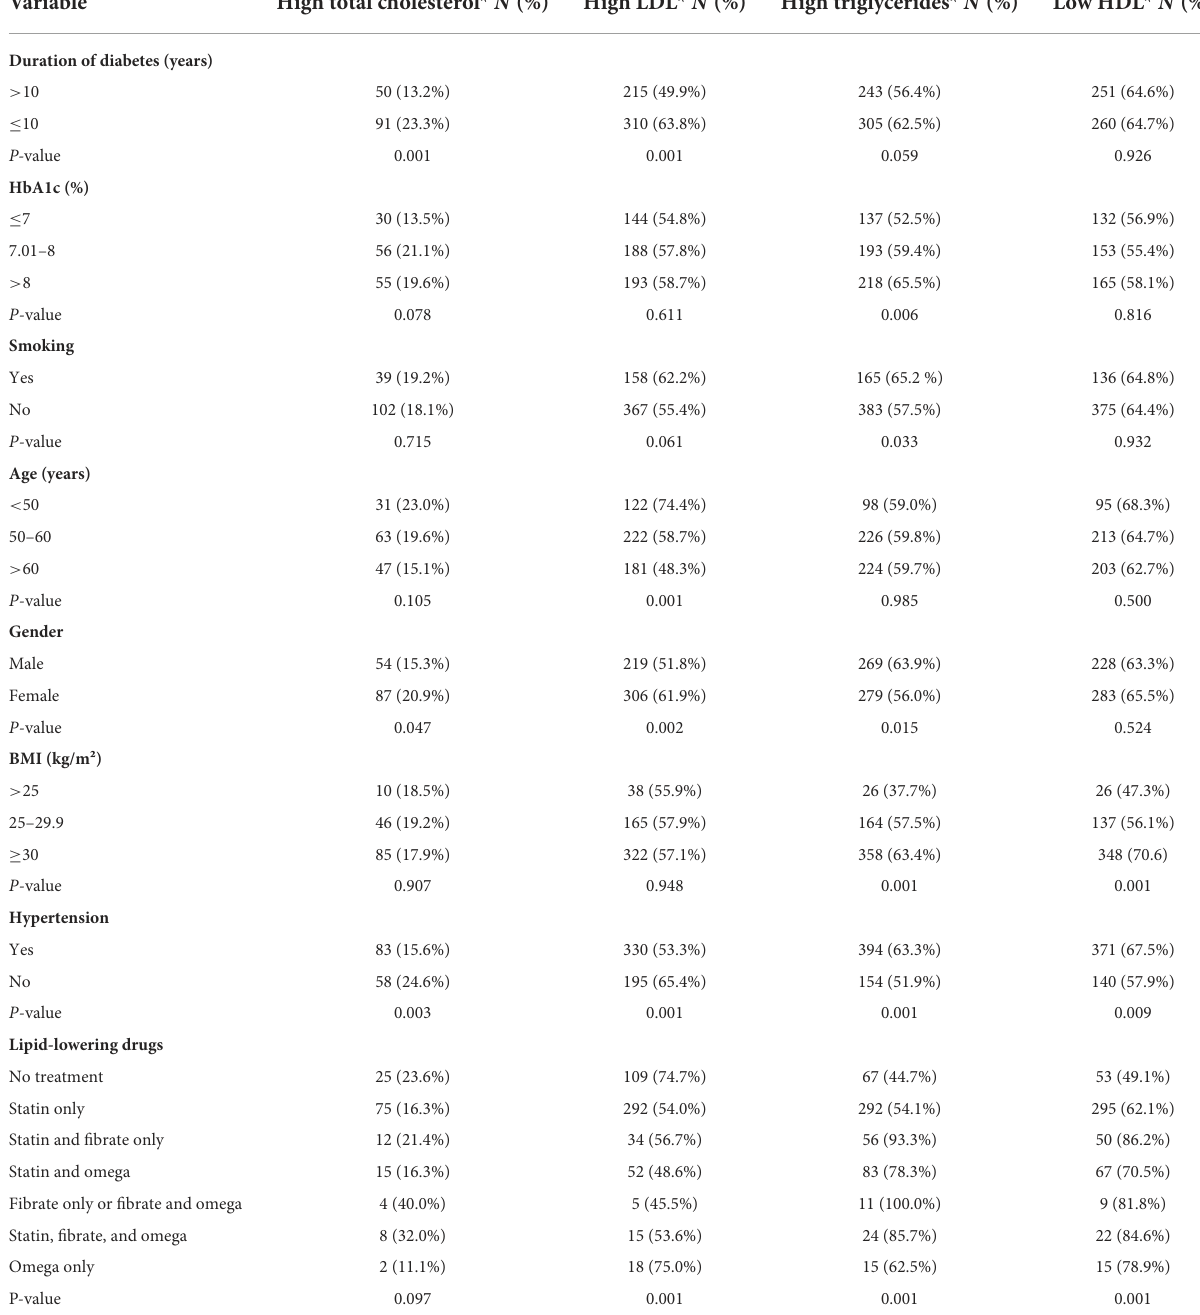
TABLE 3 Prevalence of dyslipidemia according to selected variables among patients with type 2 diabetes, Jordan, 2021 ( N = 971).